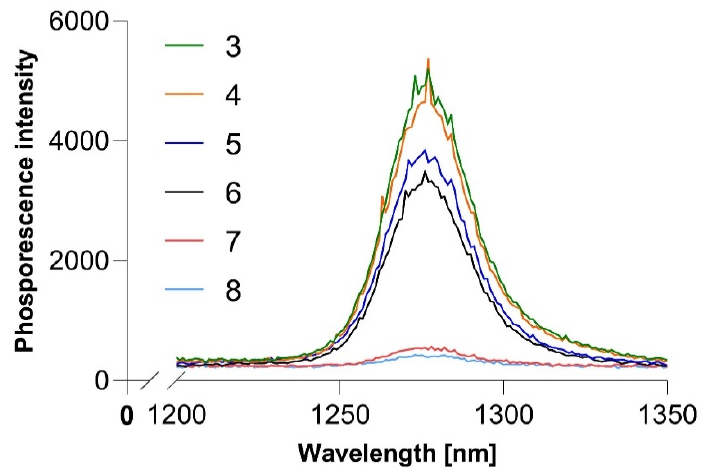
Figure 9. Singlet oxygen phosphorescence in DMF. Table 4. Singlet oxygen quantum yield of synthesized